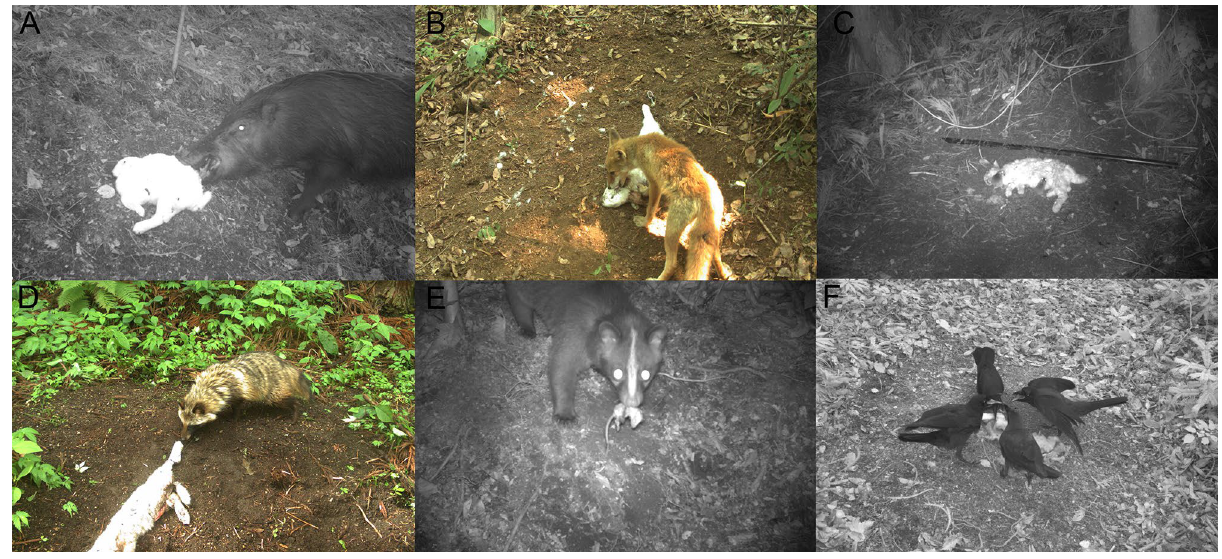
Figure 2. Frequent scavengers of rabbit and mouse carcasses in Fukushima, Japan captured by remote camera from May to July 2018. ( A ) wild boar ( Sus scrofa ), ( B ) red fox ( Vulpes vulpes ), ( C ) field mice ( Apodemus sp.), ( D ) raccoon dog ( Nyctereutes procyonoides ), ( E ) masked palm civet ( Paguma larvata ), ( F ) crows ( Corvus sp.).